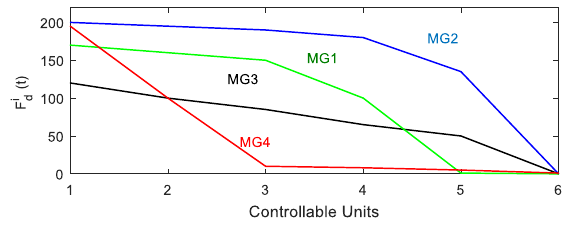
F t against the number of Figure 7. Variation of   i d controllable units in the isolated mode of microgrid .